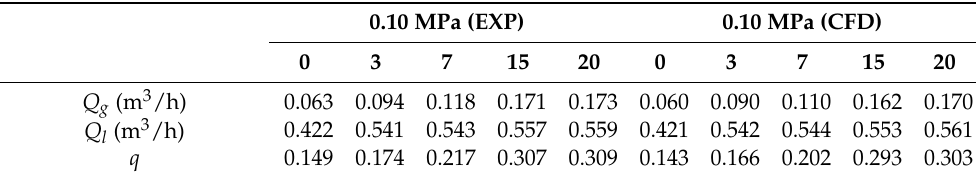
Table 1. Numerical calculation design and the